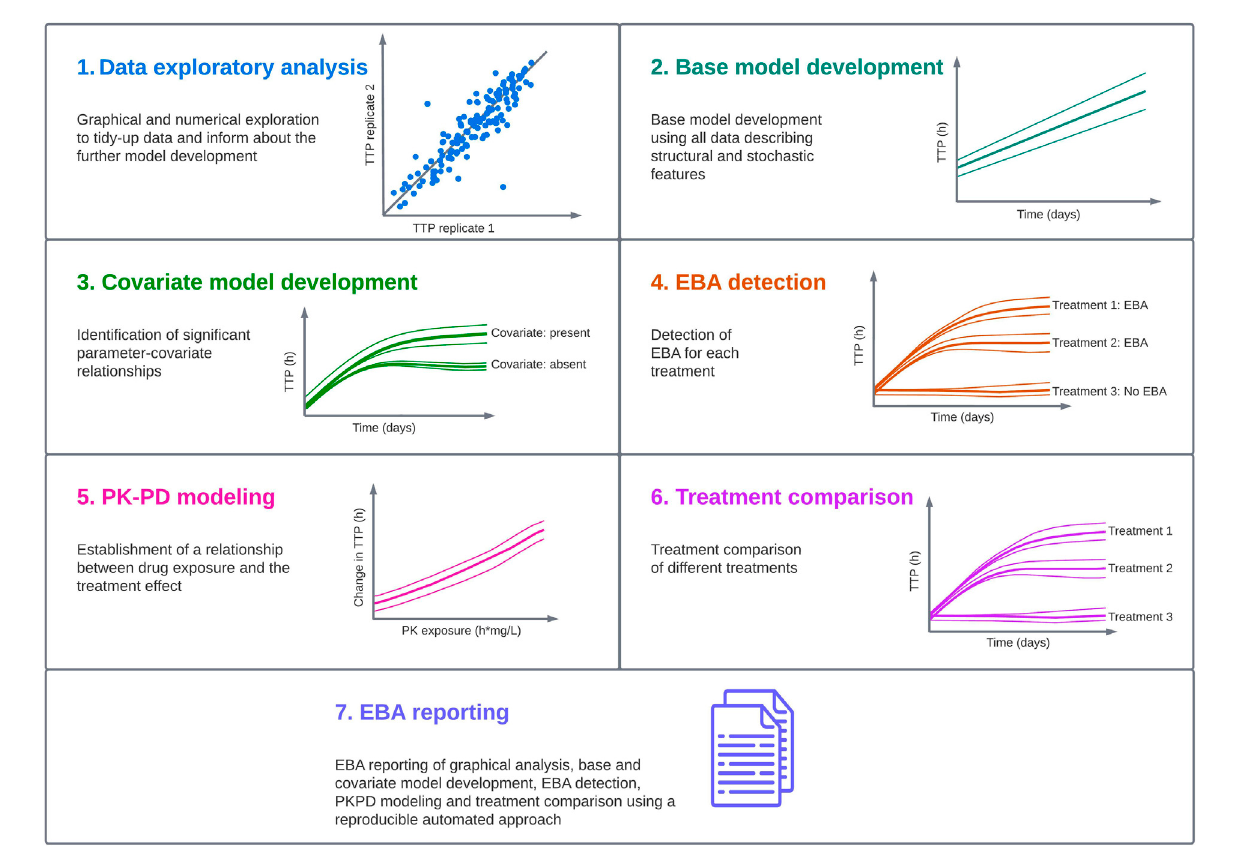
FIGURE 1 Standardized pharmacometric model-based early bactericidal activity (EBA) analysis approach was established in close collaboration between pharmacometricians, clinicians, microbiologists and data managers. In the pharmacometric model-based EBA analysis approach, the fi rst step is to perform data exploratory analysis to familiarize with the data and identify observations that could affect the analysis. In the next step, modeling is started with a base model development, and this model is used in the covariate model building to identify statistically signi fi cant parameter-covariate relationships. Afterwards, EBA detection is performed to identify treatments showing EBA. In the next step, if drug exposure information is available, pharmacokinetic-pharmacodynamic (PK-PD) modeling should be performed. This is followed by treatment comparison if multiple treatments are present in the study. In the last step, EBA reporting is done using an automated and reproducible approach to ensure consistency, and the predictions of EBA on typical and individual levels are